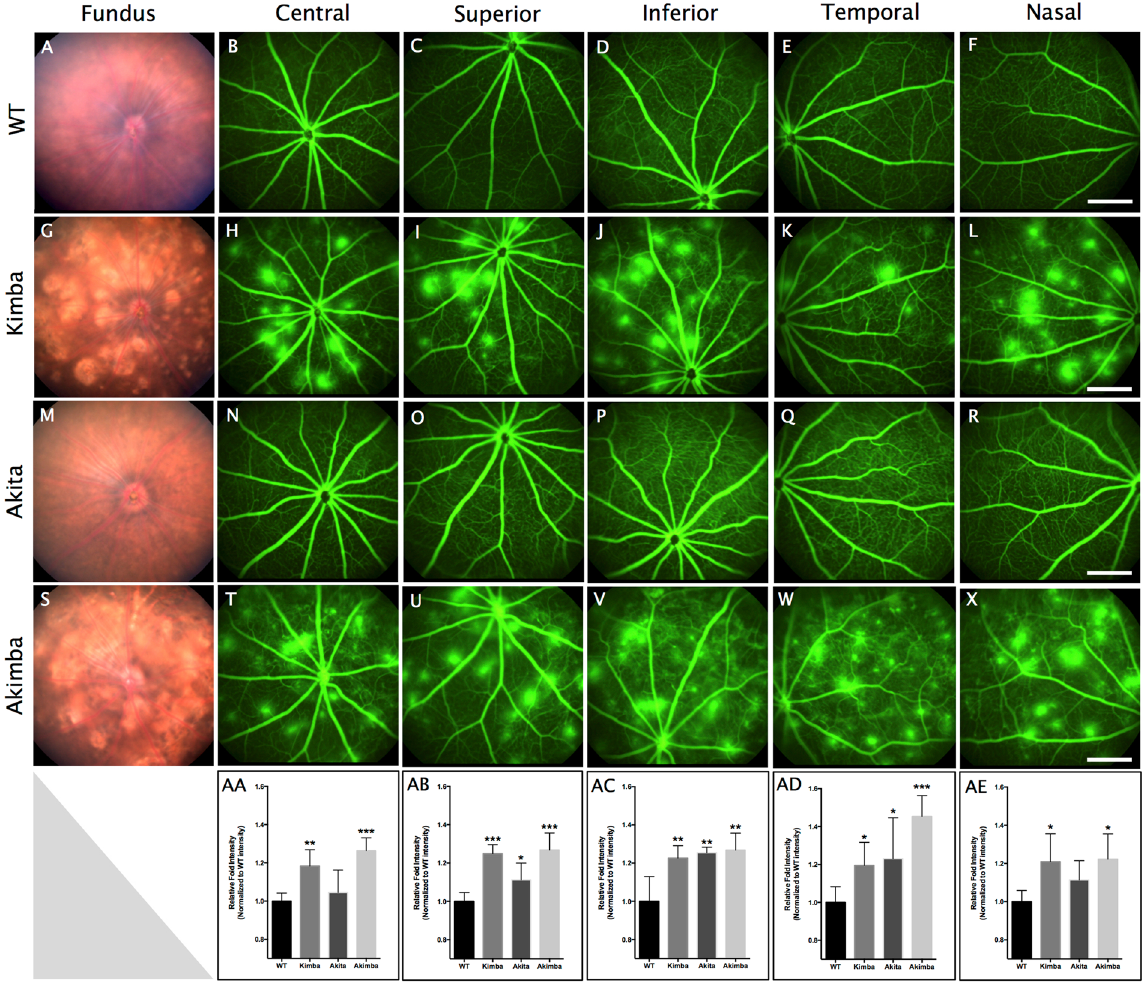
Figure 1. Color fundus photographs and Fundus fluorescein angiograms (FFA) of wild -type (WT), Kimba, Akita and Akimba mice. WT mouse showed regular arterial and venular caliber, branching, and tortuosity in the retina ( A – F ). Kimba mice had multiple spots of hyperfluorescein (bright spots) throughout the retina ( G – L ). Akita mice displayed a slight increase in tortuosity with no signs of leakage ( M–R ). Double transgenic Akimba mice showed vasculature abnormalities inherited from parental strains, with high severity of leakages accompanied with tortuosity and significant loss of capillary density ( S – X ). Relative fluorescein intensity calculated using mean grey area measurement of FFA images showed a significant increase in fluorescein leakage in Akimba mice across all photographed areas of the retina ( AA–AE ). n = 8 animals in each group. * p < 0.05; ** p < 0.01 and *** p < 0.001 compared to WT group. Data represent mean ± SD. Scale bar, 500 µ